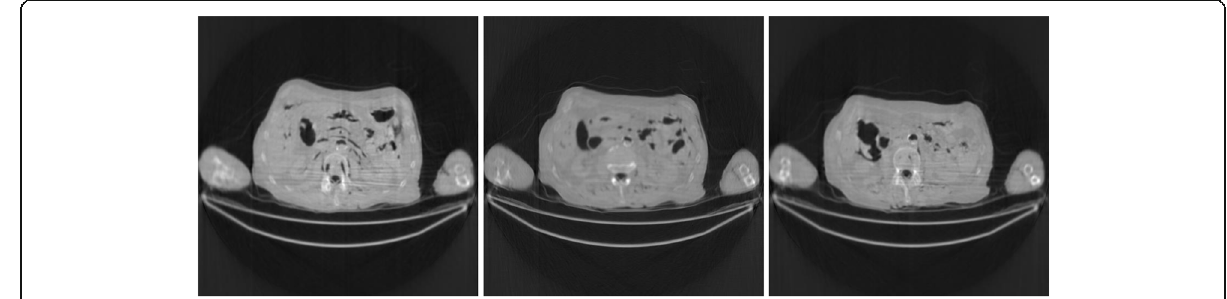
Fig. 7 FBP reconstruction of three image slices using a stationary Gaussian pre-filter h whose σ h is defined in Eq. (5) with a = 0 and c = 2. Left to Right: Slice 1, Slice 32, and Slice